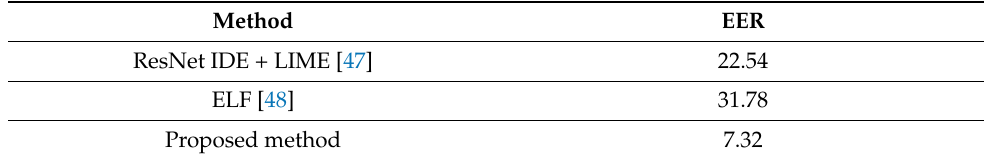
Table 19. Comparison of EERs using the proposed method and state-of-the-art face and body recognition methods with an open database (unit: %).